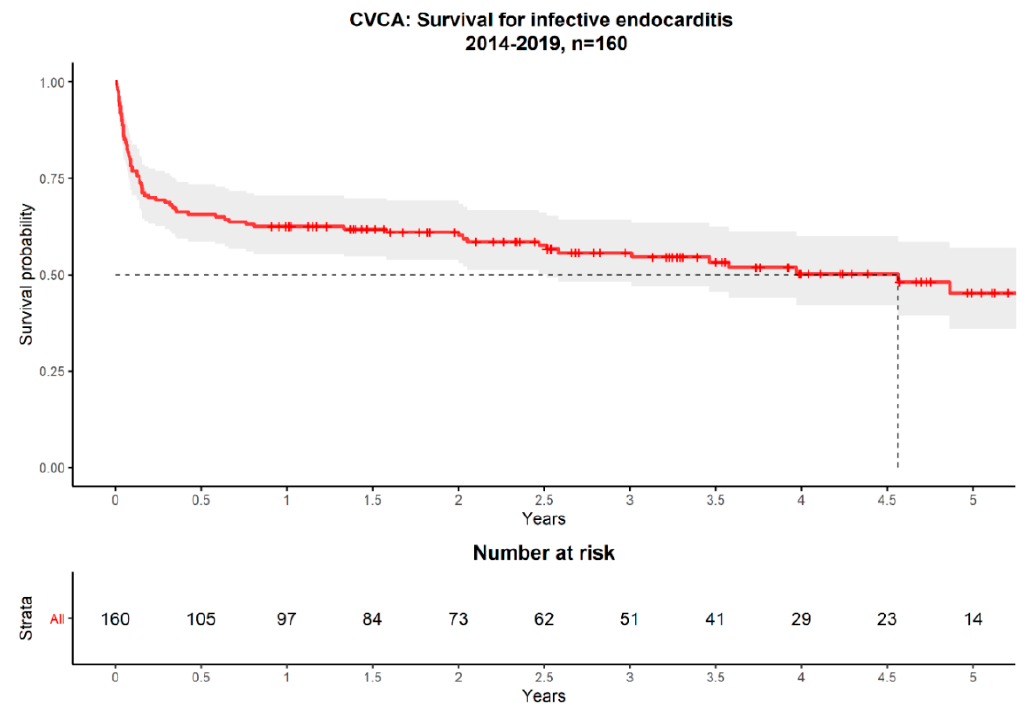
Figure 1. Overall survival curve of the CVCA registry 2014–2019.